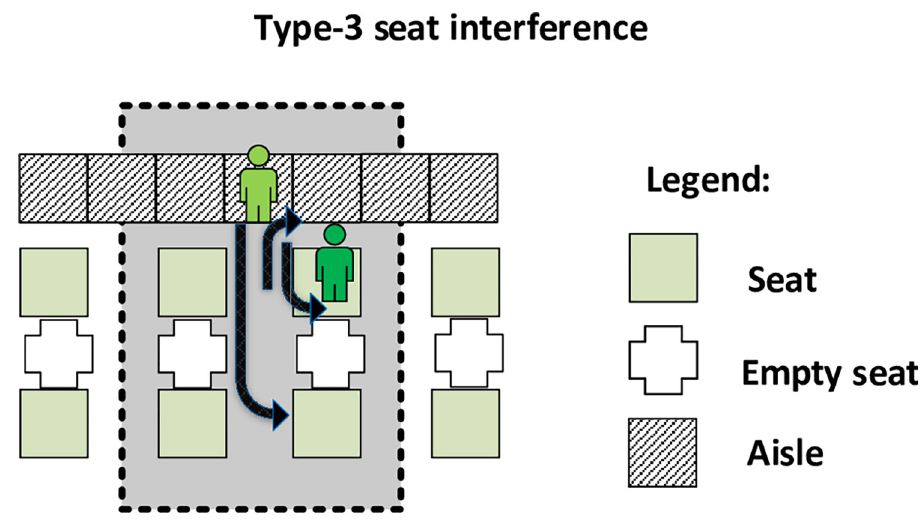
Fig 7. Type-3 seat